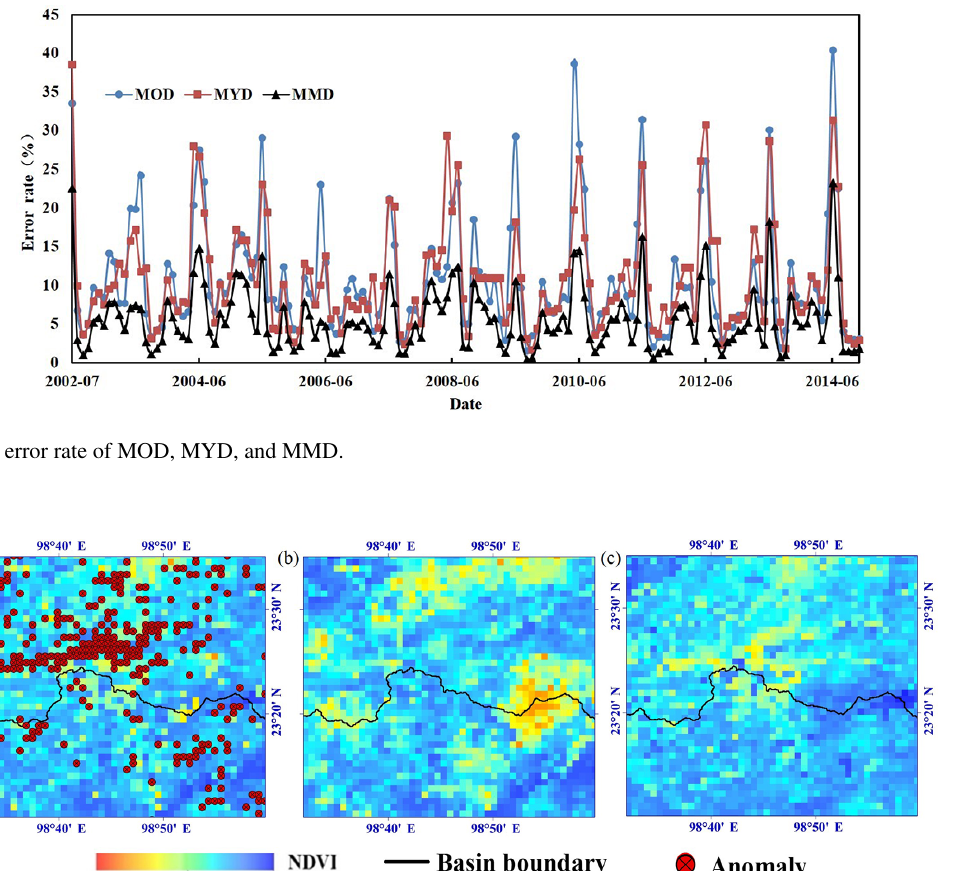
Hydrol. Earth Syst. Sci., 21, 999–1015,